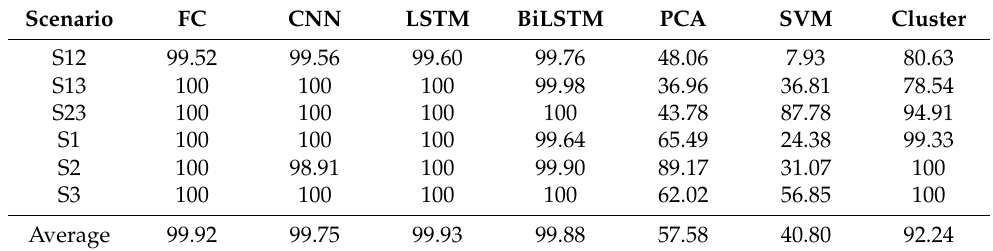
Table 4. Evaluation of the effectiveness in normal operating conditions: average F1